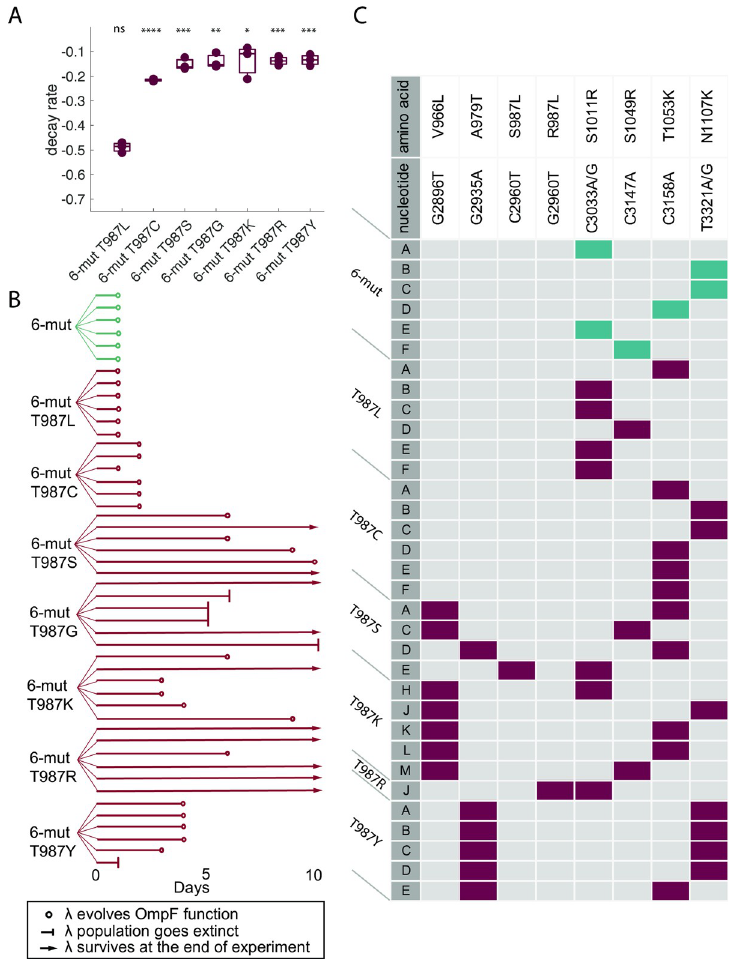
Fig 3. Evolution experiment with engineered library genotypes. We generated additional variants of 6-mut differing only at the amino acid at position 987 in J. A: Most variants were more thermostable than 6-mut, but T987L remained as unstable as 6-mut. N = 3 replicates per genotype. Comparisons to 6-mut decay rate were made using paired t-tests corrected for multiple comparisons by the Bonferroni method (6-mut T987L: p = 0.510; 6-mut T987C: p = 7.58 x 10 − 8 , 6-mut T987S: p = 1.02 x 10 − 5 , 6-mut T987G: p = 1.26 x 10 − 4 , 6-mut T987K: p = 8.55 x 10 − 4 , 6-mut T987R: 2.96 x 10 − 6 , 6-mut T987Y: p = 7.26 x 10 − 6 .) B: We measured the evolvability of OmpF + in each variant using a nearly identical evolution experiment as in Fig 2A and 2B. C: A single plaque from each replicate population was sequenced on the first day OmpF + was detected. Mutations are indicated along the top. Boxes with colored fill indicate that the amino acid change occurred in an isolate. The fill color indicates the stability of the genotypic background in which the mutation evolved (teal = 6-mut, dark red = engineered codon 987 variants.) Population IDs are indicated by letters. Asterisks along the lines indicate significant differences in decay rate between the genotypes connected by the line (Bonferroni adjusted significance: ns: P > 0.05, � : P < 0.05, �� : P < 0.01, ��� : P < 0.001, ���� : P < 0.0001).